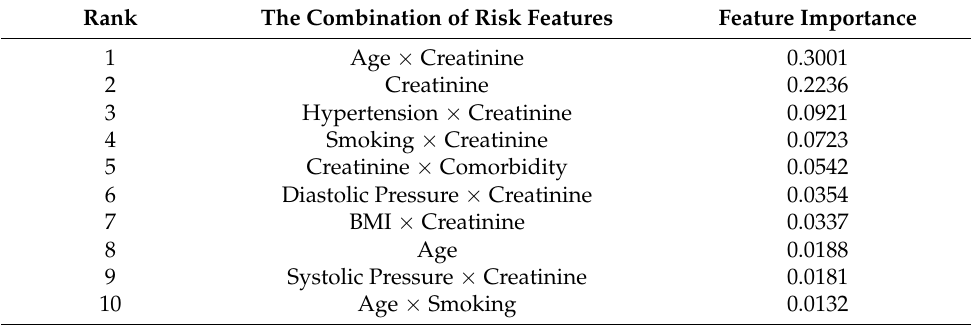
Table 3. The top 10 ranked feature importance for CKD third stage